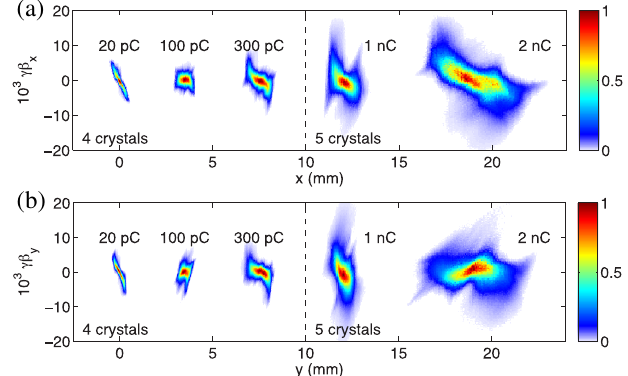
FIG. 7. Measured horizontal (a) and vertical (b) phase spaces as a function of bunch charge.